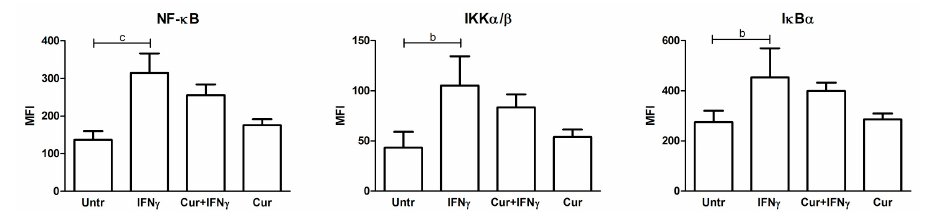
Figure 7. Multiplex analysis of phosphorylated proteins of NF- κ B pathway in curcumin pre-treated HT29 cells. HT29 cells were pre-treated with curcumin (Cur) and then, after 24 h, stimulated with IFN γ for a further 48 h to detect changes in phosphorylated proteins belonging to the NF- κ B pathway (NF- κ B, IKK α / β , and I κ B α ), using a magnetic bead signaling kit and a Bio-Plex multiplex reader. Data, expressed as the median fluorescence intensity (MFI), represent the mean ± SD of four replicates and were analyzed with one-way ANOVA using the Bonferroni post-test (b: p < 0.01; c: p < 0.001). 3.5. Downregulation of the IL7 Secretion by Curcumin The IFN γ treatment induced an increase of IL7 release in the HT29 culture media (Untr: 21.51 ± 2.40 vs. IFN γ : 88.76 ± 15.01, p < 0.001, Figure 8). When administered 24 h before the inflammatory stimulus, curcumin led to a significant downregulation of the levels of cytokines secreted, compared with the values obtained after the administration of IFN γ alone (IFN γ : 88.76 ± 15.01 vs. Cur -24h + IFN γ : 54.54 ± 5.25, p < 0.01, Figure 8). With respect to the other analytes, no significant and biological differences were found between the four analyzed conditions (data not shown).